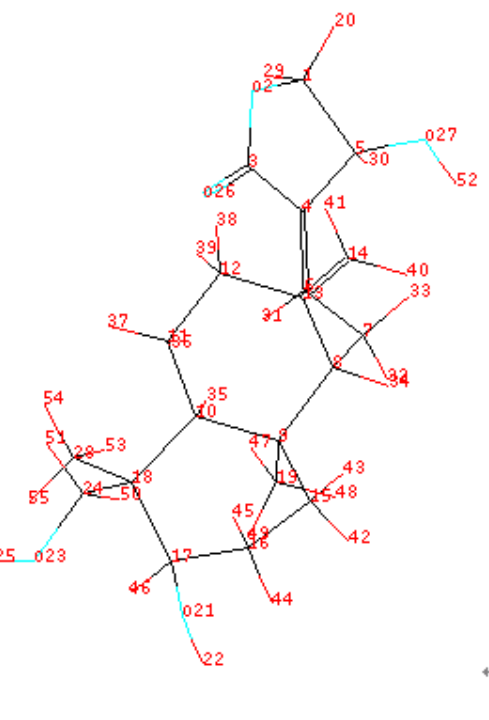
Figure 4. Structure of